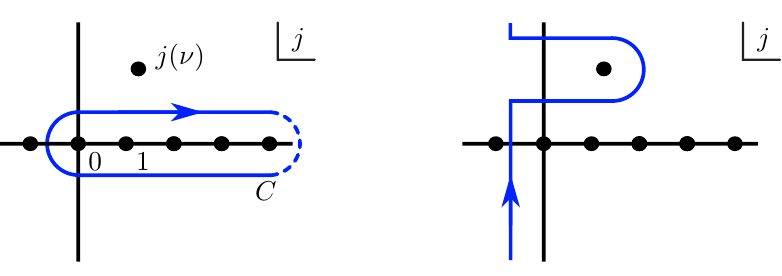
Figure 4 . First step of the Sommerfeld-Watson transform in S-matrix theory. The contour should remain to the right of j -plane singularities. The contours are equivalent in Euclidean kinematics but the second one allows a safe continuation to